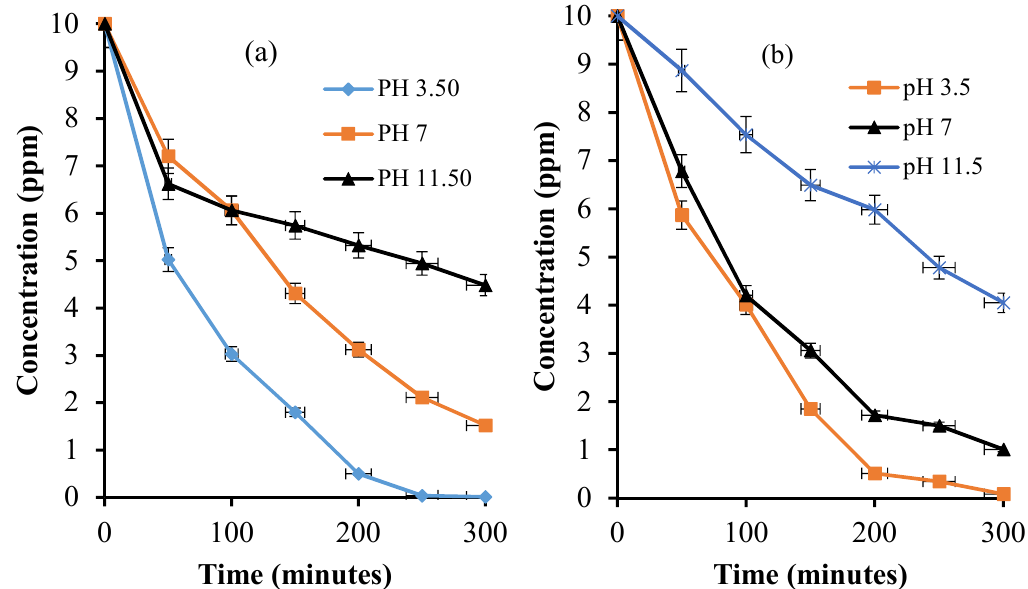
Figure 9. Photodegradation profiles of ( a ) MO and ( b ) GY dyes obtained by using the 2%C-TiO 2 -CFA/PAN photocatalytic membrane under sunlight irradiation (109,800 lux of light intensity), while varying pH.